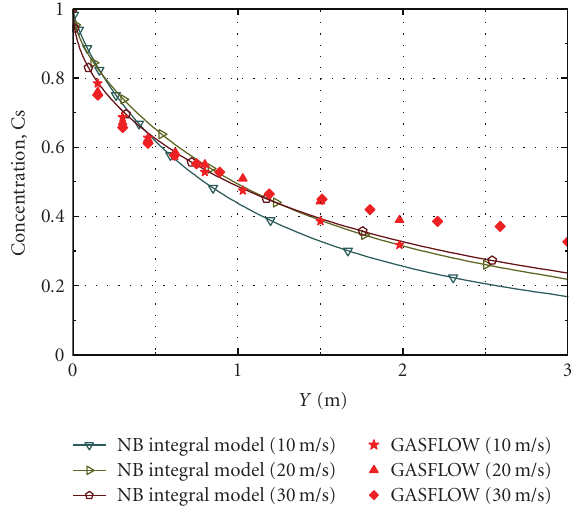
Figure 11: Concentration decay of horizontal buoyant jet with large density